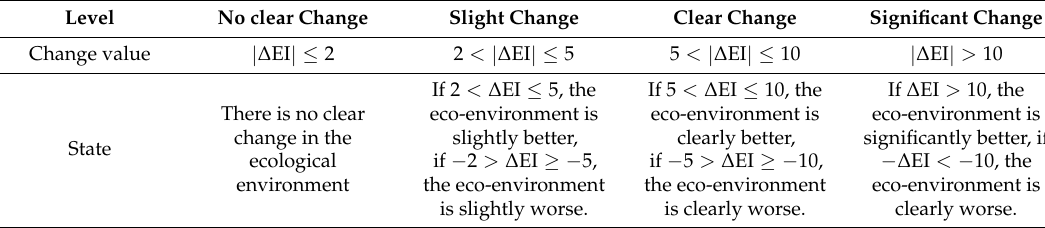
Table 10. Grade of variation of eco-environmental quality (HJ/T192-2006).